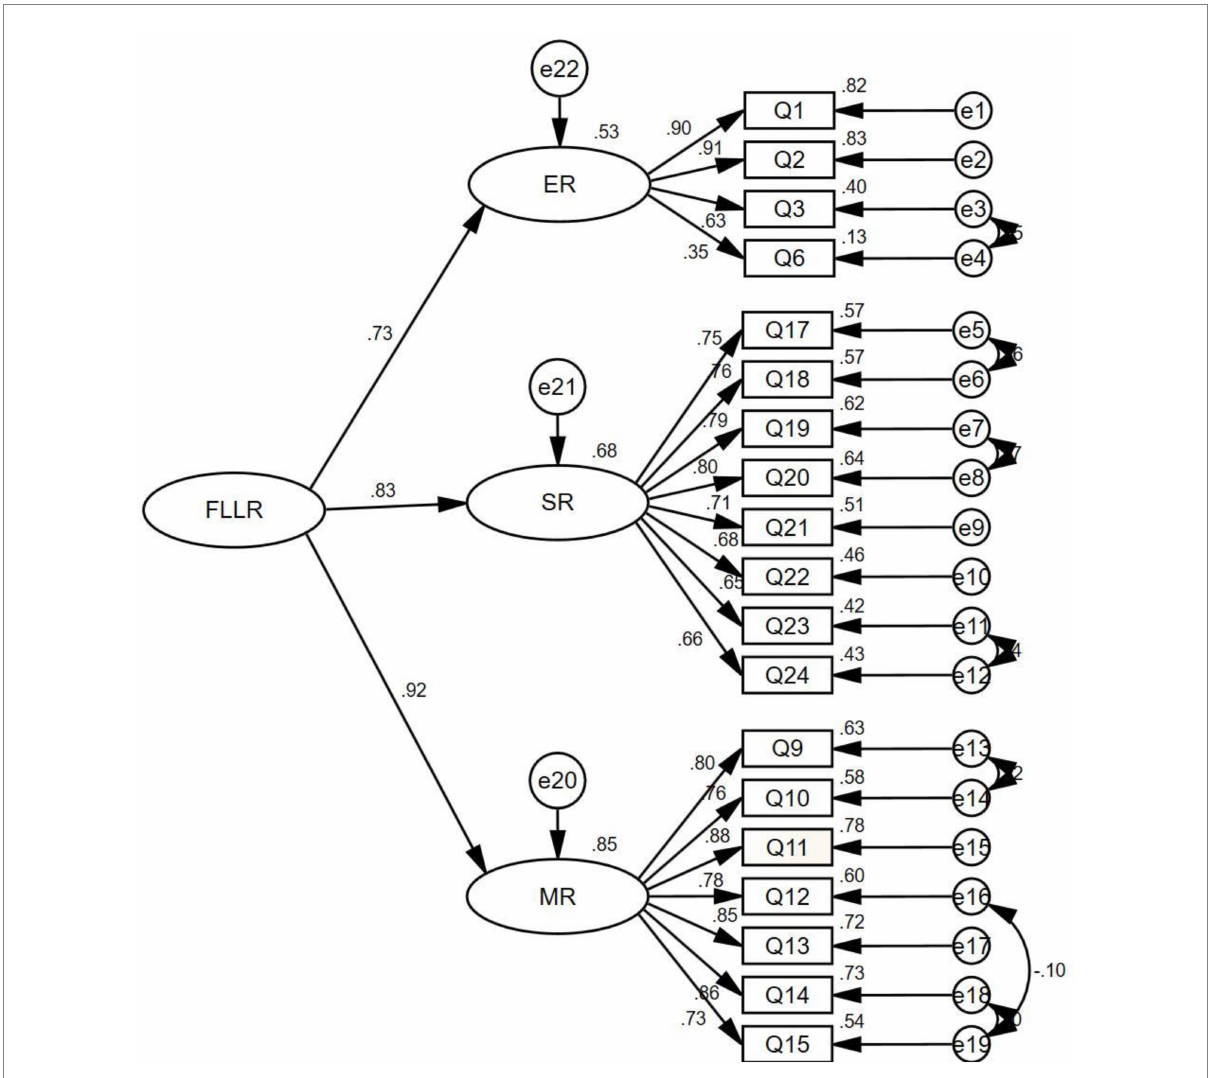
FIGURE 1 Confirmatory factor analysis results for the three-factor structure. N = 313, χ 2 = 359.597, df = 142, p < 0.001. FLLR, foreign language learning resilience; ER, ego resilience; SR, social resilience; MR, metacognitive